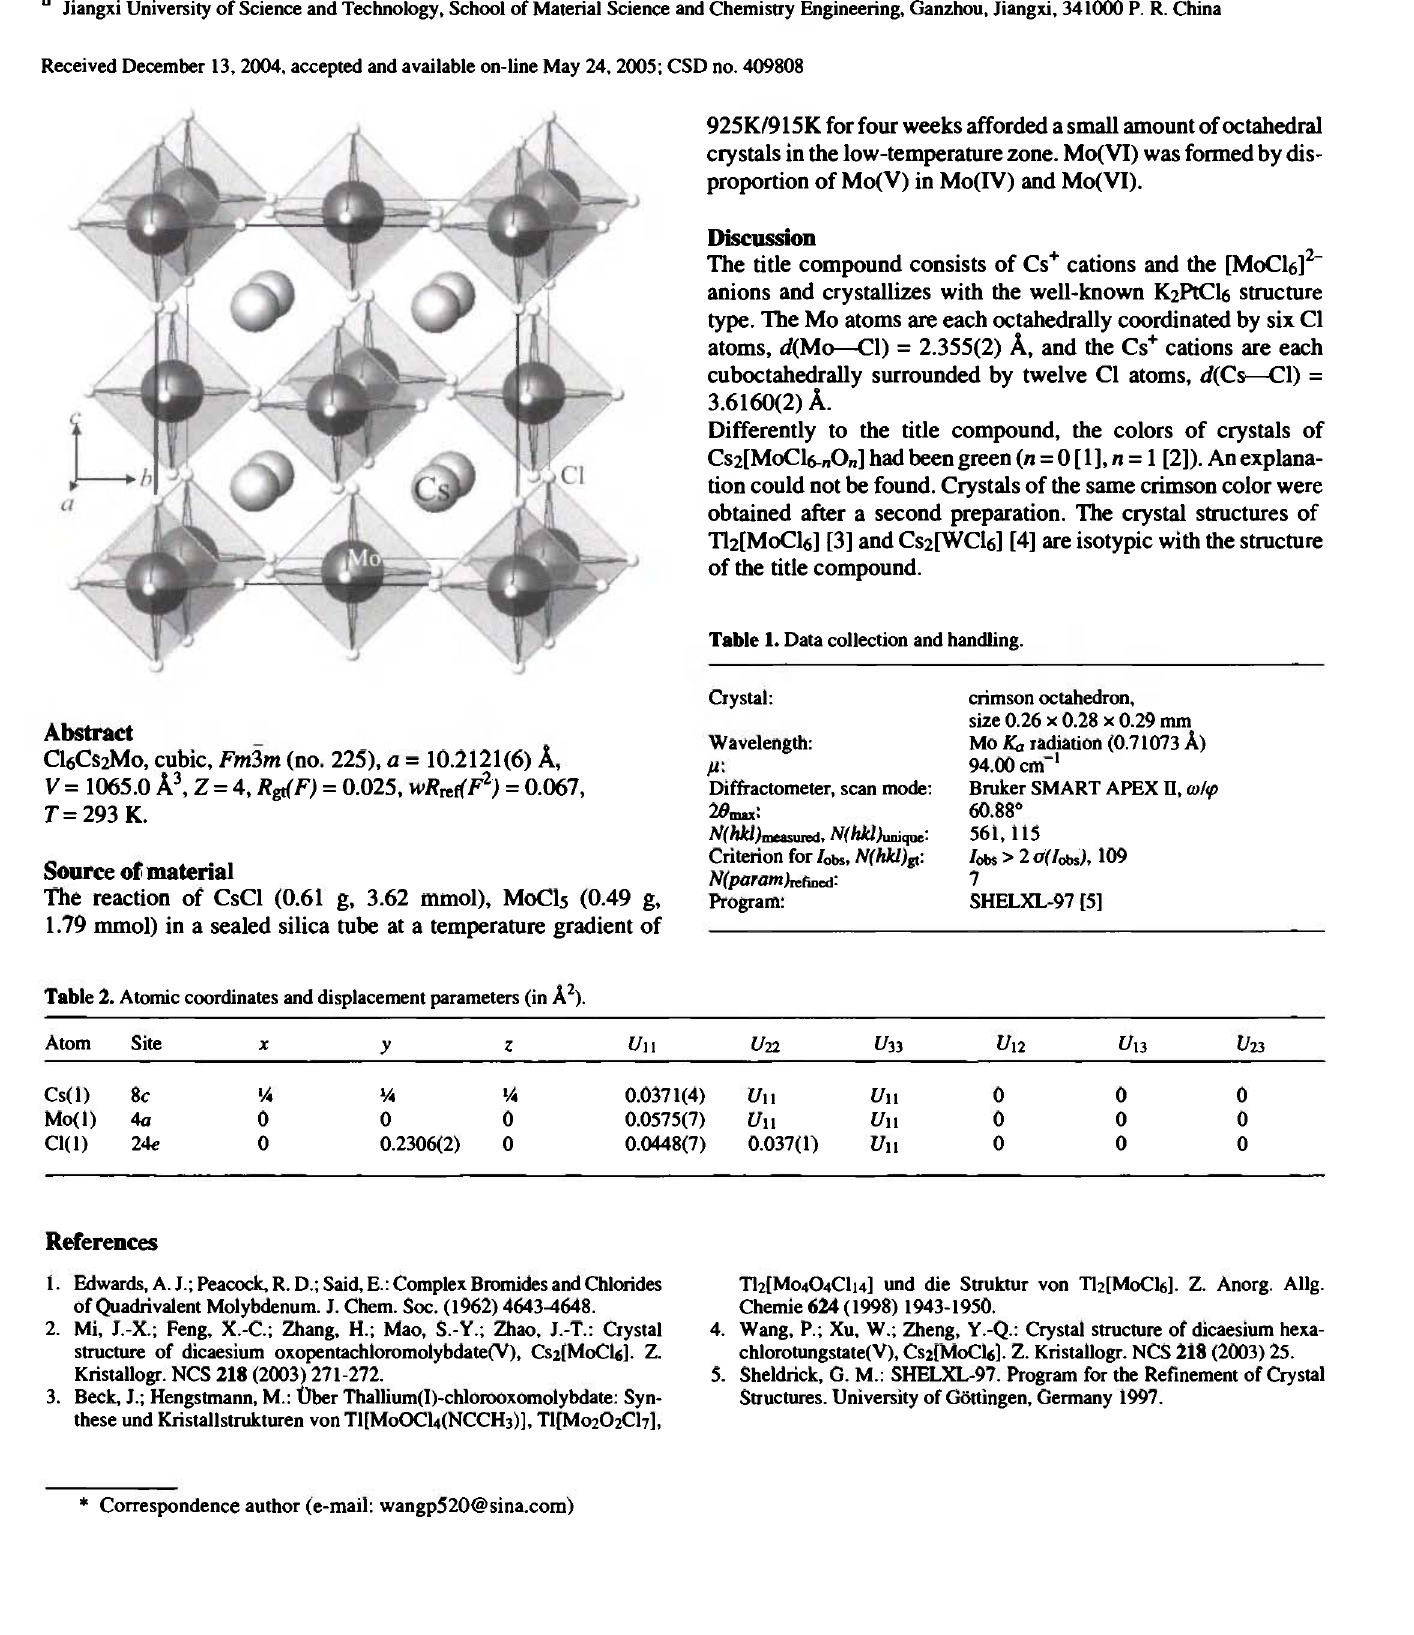
Table 1. Data collection and handling.